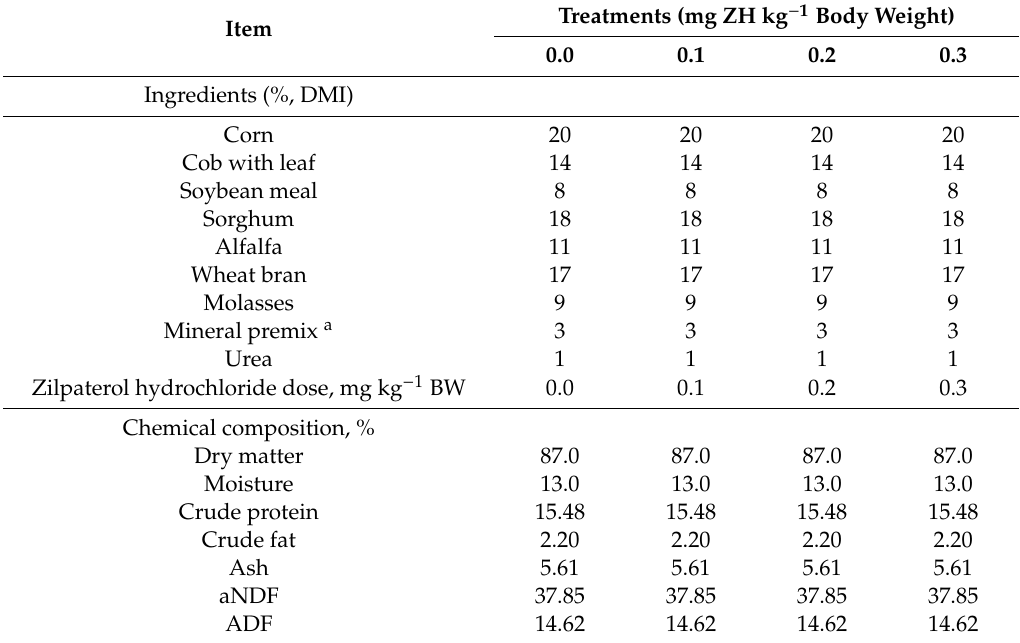
Table 1. Ingredients and chemical composition of the experimental diets.